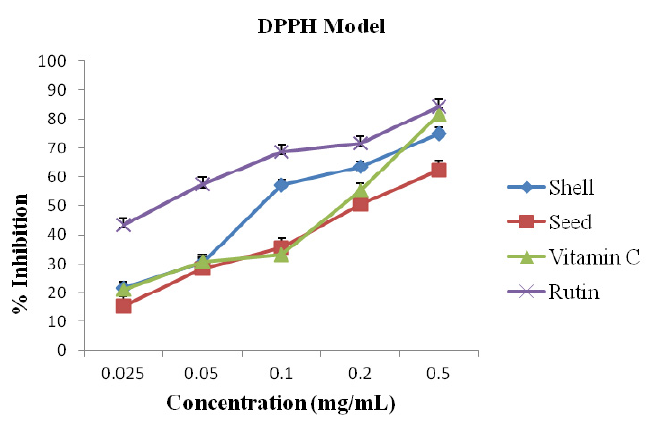
Figure 2. Antioxidant activity of the shell and seed essential oils extracted